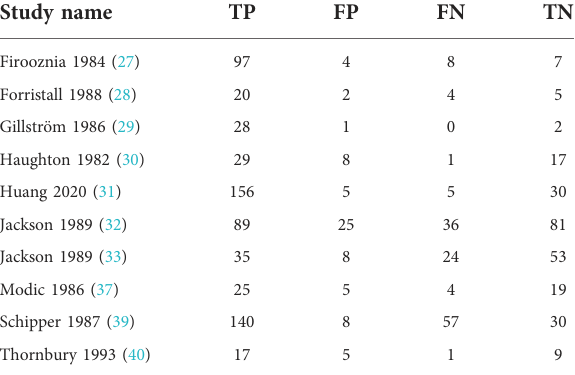
TABLE 3 Characteristics of CT diagnostic tests.